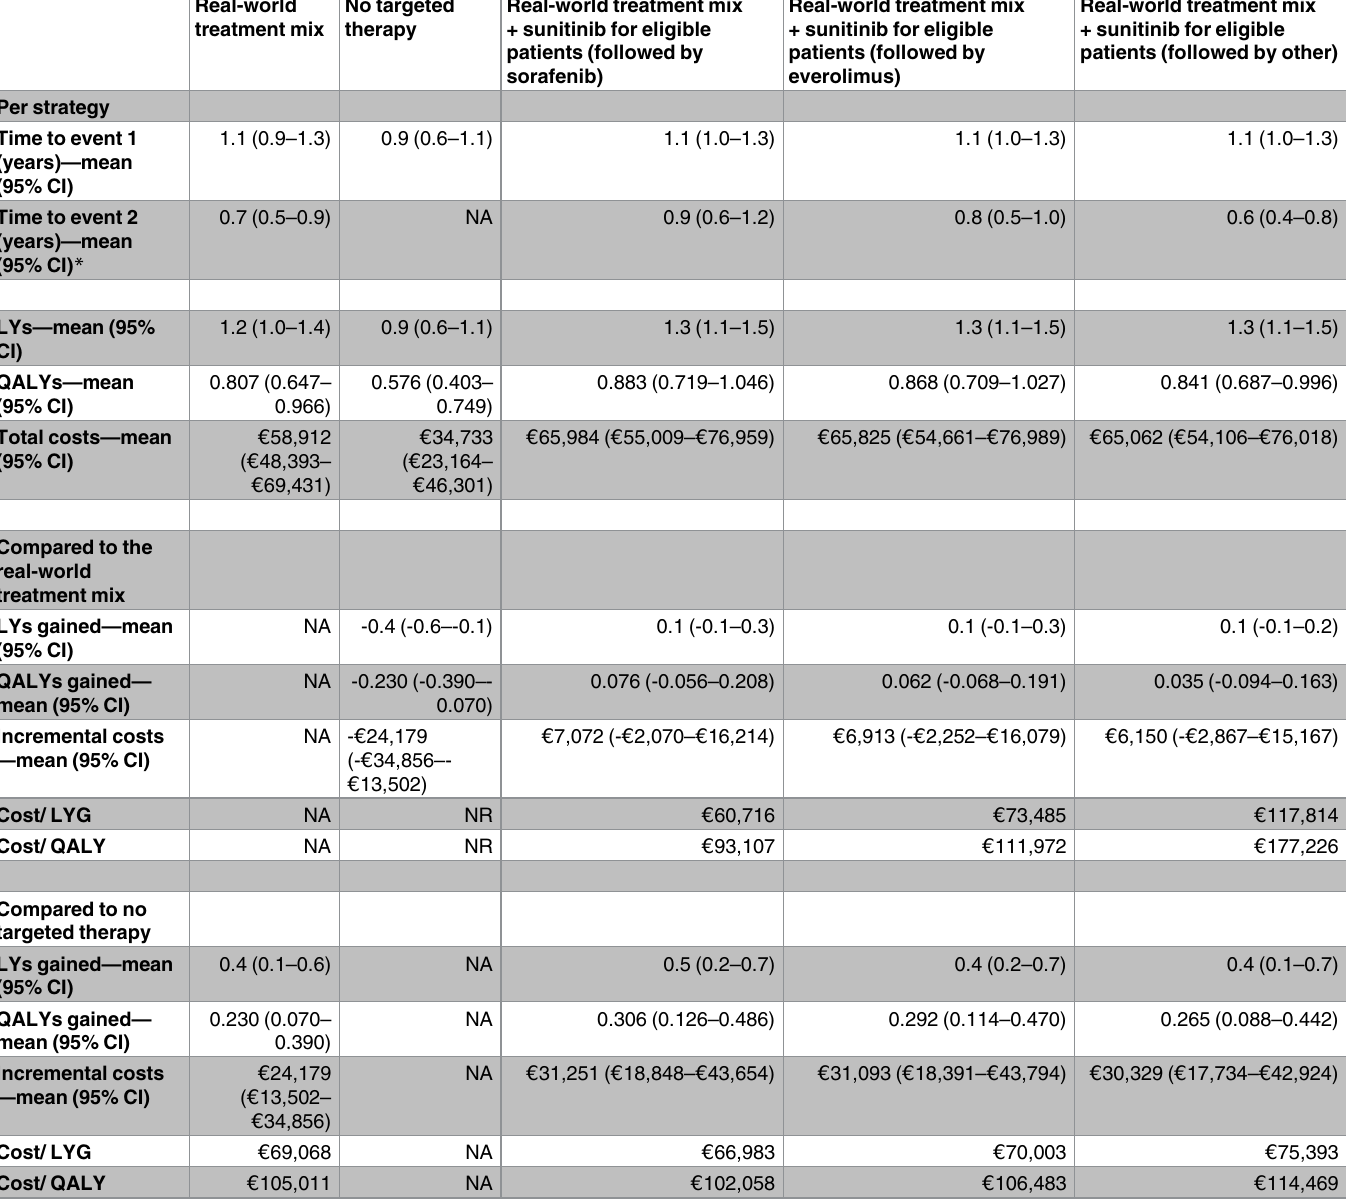
Table 3. Summaryof the